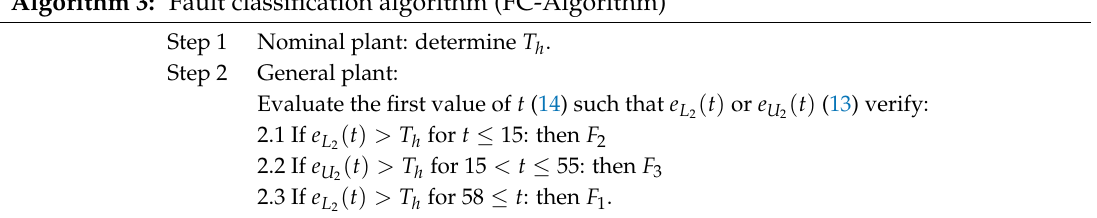
Algorithm 3: Fault classification algorithm (FC-Algorithm)